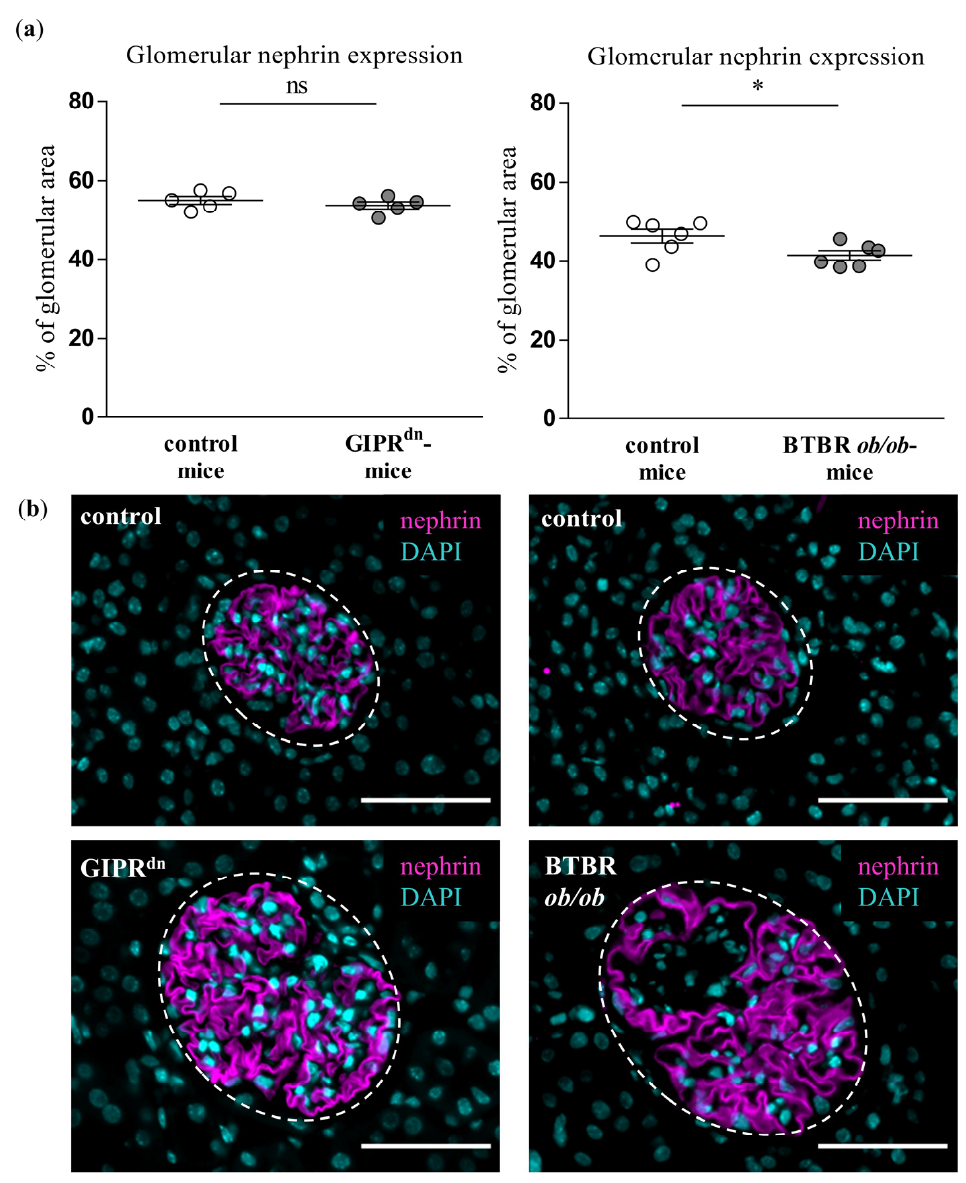
Figure 5. Analysis of nephrin in diabetic kidney disease models. ( a ) Automatic histological evaluation of nephrin-positive area in glomeruli of GIPR dn mice ( left , diabetes mellitus type 1 model) and BTBR ob/ob mice ( right , diabetes mellitus type 2 model) compared to their corresponding healthy control mice. Scatter dot plot with means and SEM, * p < 0.05, ns: not significant, n = 5–6. ( b ) Representative images of histological kidney sections stained for nephrin (magenta) and the nuclear marker 4 ′ ,6-diamidino-2-phenylindole (DAPI, cyan). The dashed line borders the glomeruli. Scale bar: 50 µm.